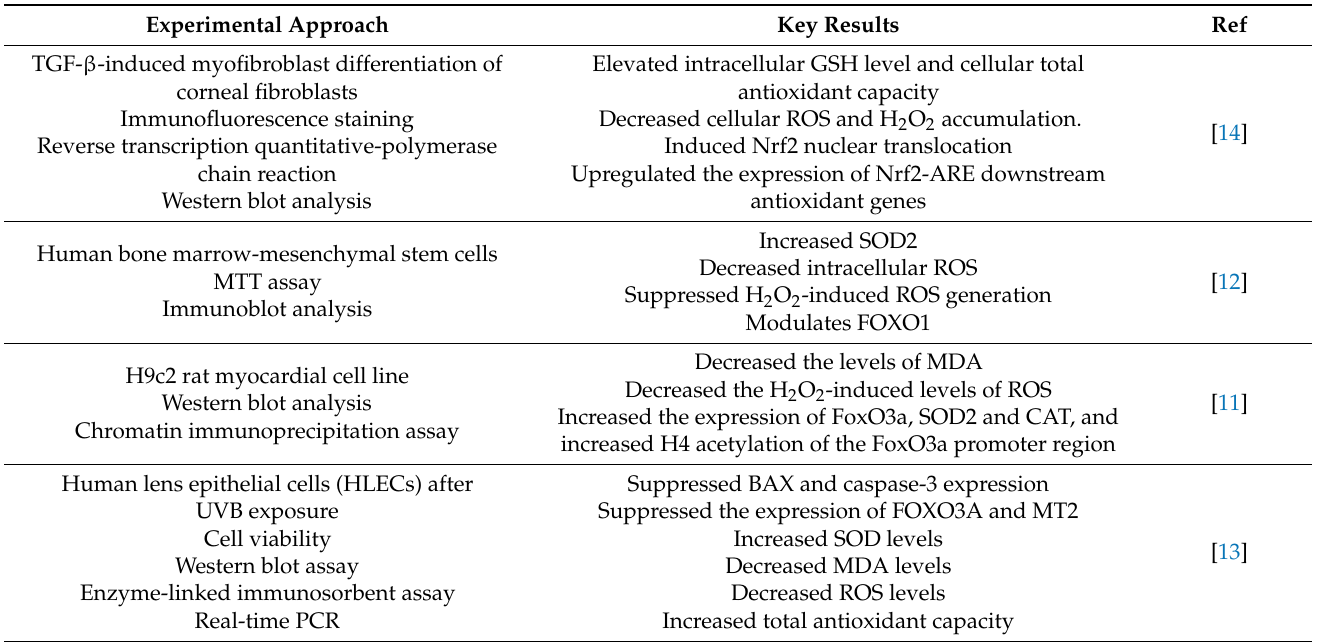
Table 1. Antioxidant effects of